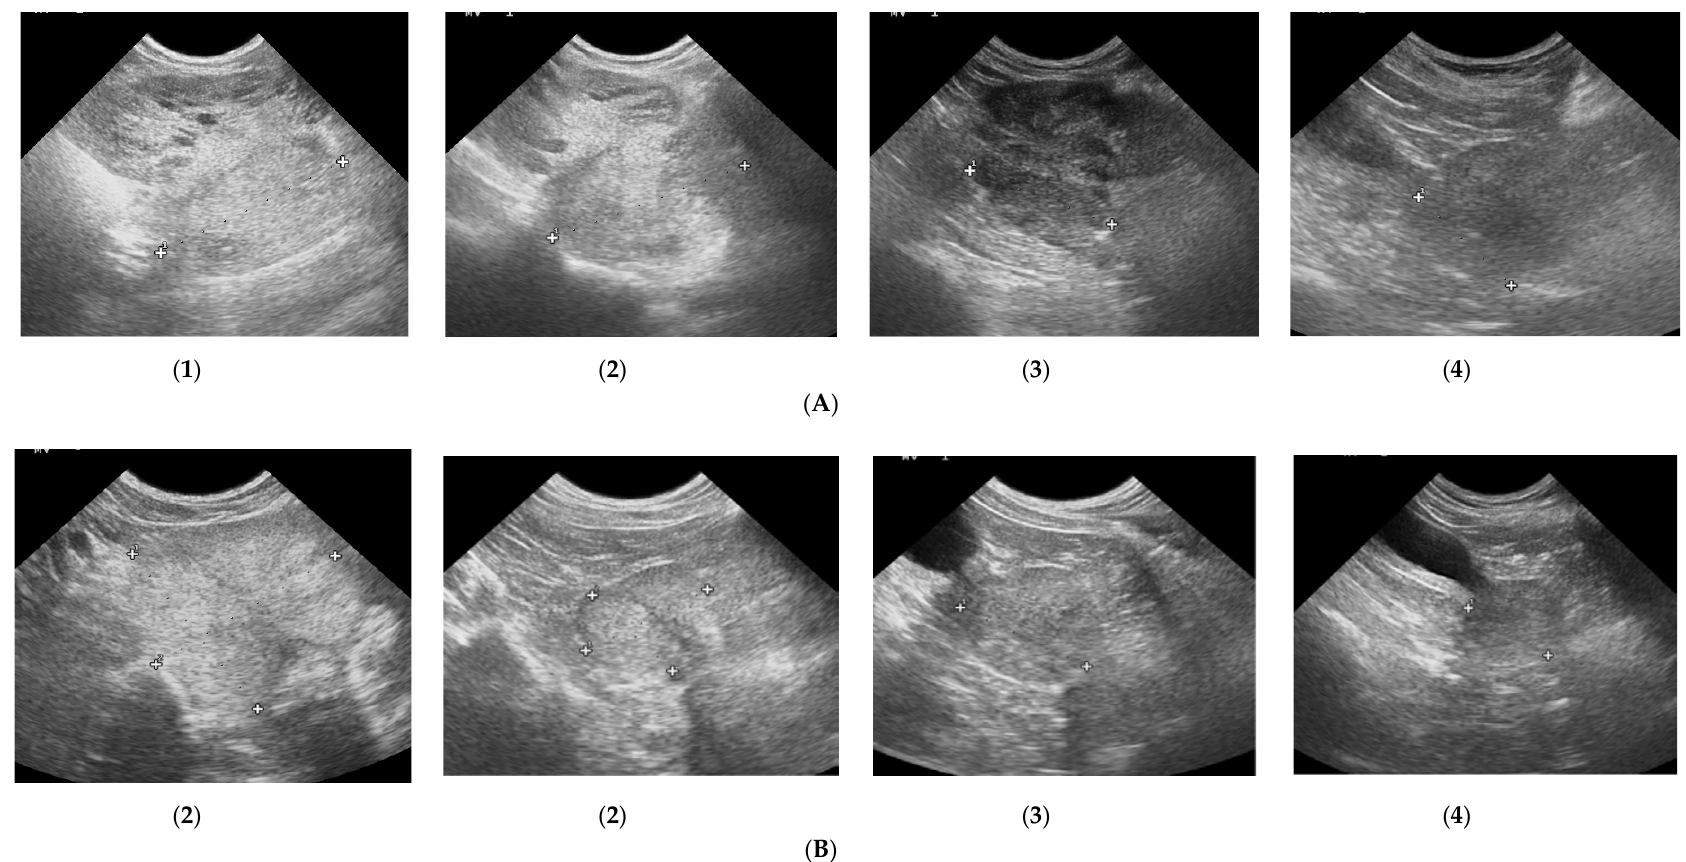
Figure 2. Changes in B-mode prostate imaging in dogs receiving deslorelin acetate, visible gradual involution of multiple cysts, and changes in echogenicity of the prostatic parenchyma. Letters ( A ) and ( B ) correspond to a single patient in the following examinations on days: ( 1 )—day 0; ( 2 )—week 8; ( 3 )—week 16, and ( 4 )—week 24. ( A )— dog with large and multiple parenchymal cysts (>10 mm), sagittal view, right lobe indicated in pictures; ( B )—dog with small and multiple parenchymal cysts (<10 mm), transverse view, the prostate gland indicated in pictures .